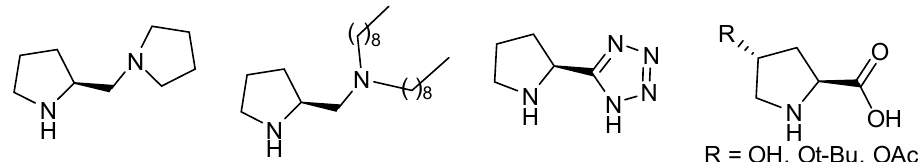
Figure 1. Examples of common L -Proline-derived organocatalysts.